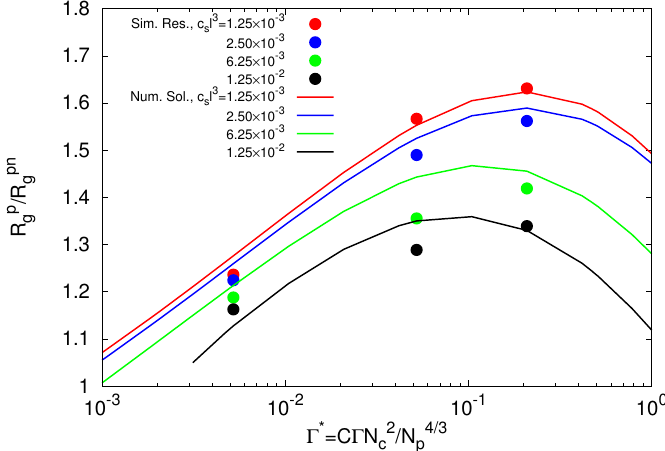
Figure 8. Average radii of gyration R p g of individual polymers as a function of the interaction strength Γ ∗ for microgels with N c = 147 and various salt concentrations c s . The average radius of gyration of the neutral system is R pn g / l = 2.6. The theoretical curves follow for the parameters C = 0.032 and ˆ C =